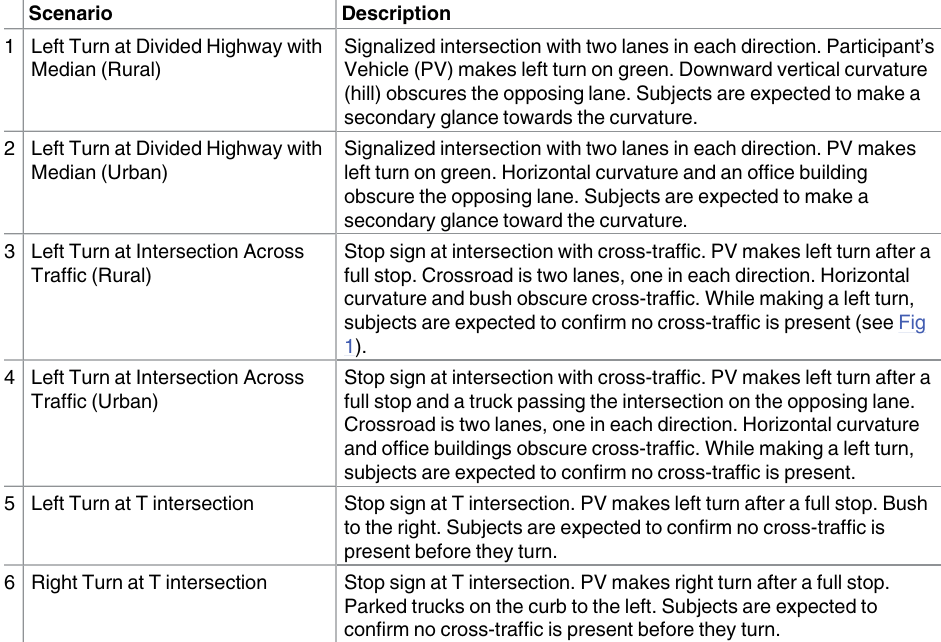
Table 1. Intersection scenarios and the corresponding location of target